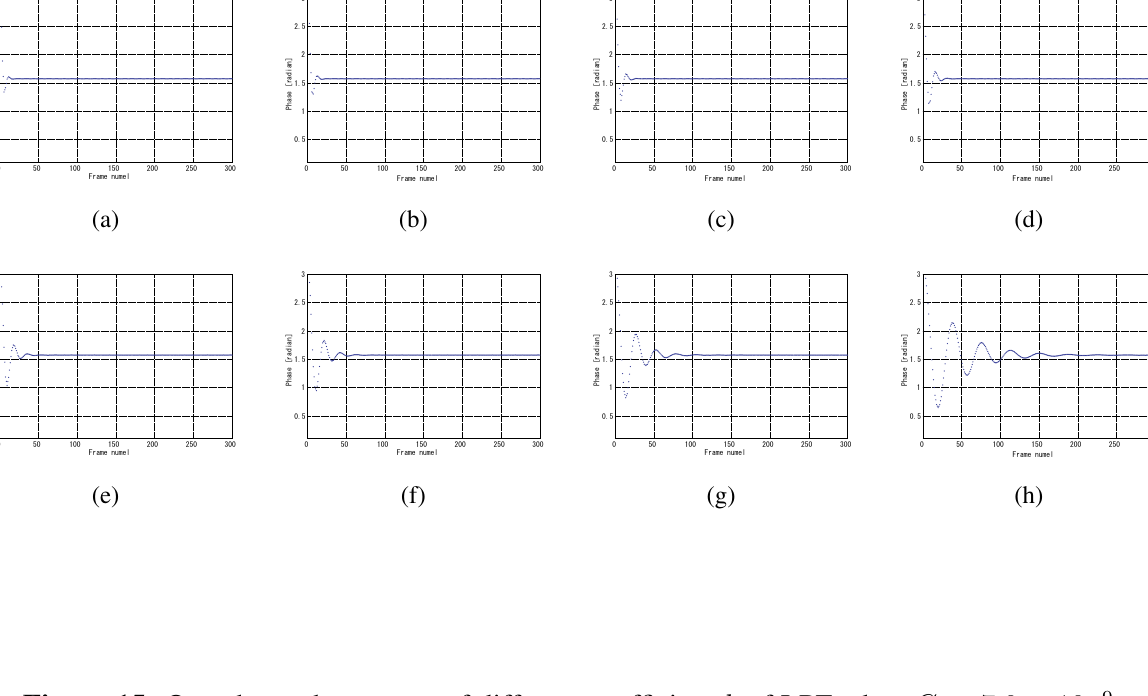
Figure 15. Overshoot phenomena of different coefficient k of LPF when G = 7 . 0 × 10 − 9 , (a) k = 0.0156, (b) k = 0.0125, (c) k = 0.2500, (d) k = 0.3750, (e) k = 0.5000, (f) k = 0.6250, (g) k = 0.7500, (h) k =